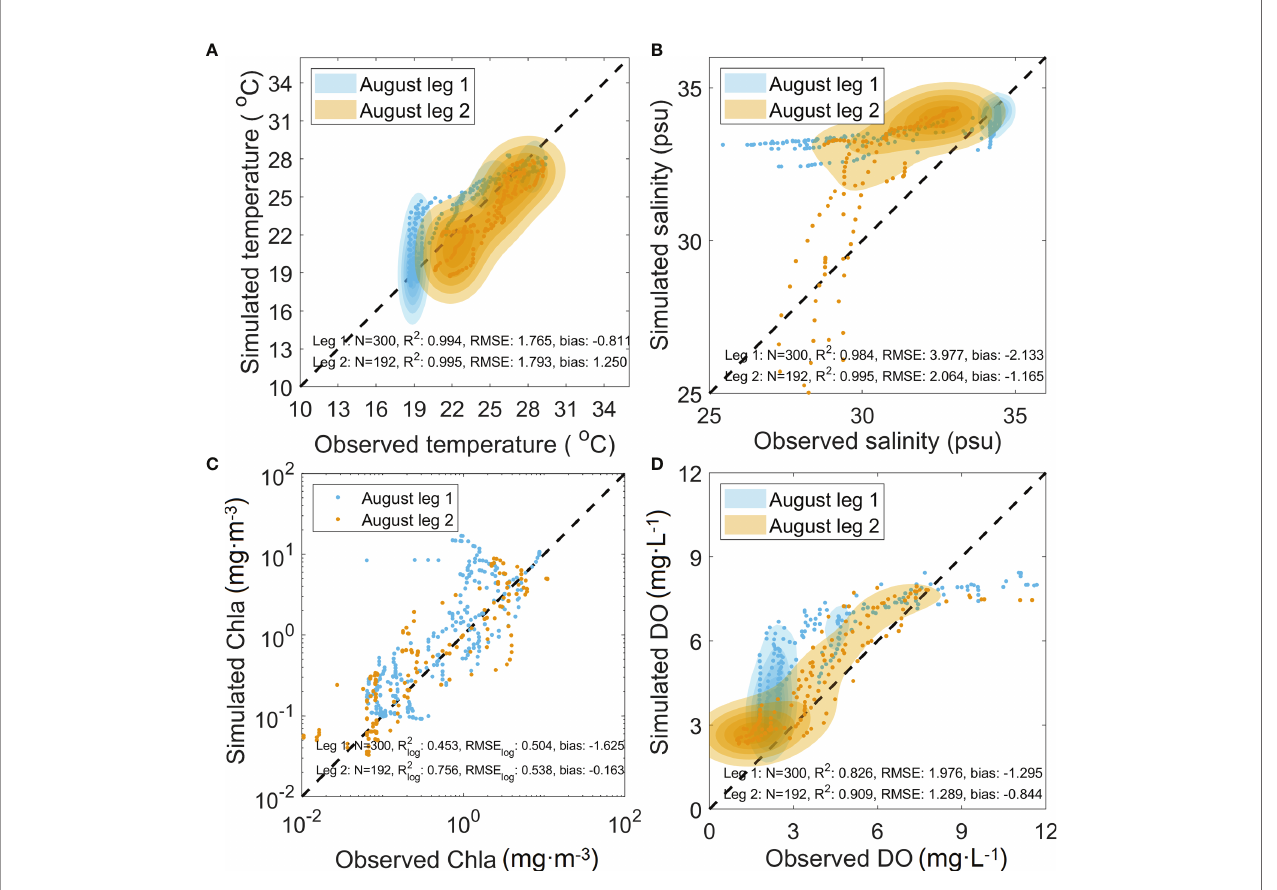
FIGURE 4 | Point to point comparisons between the survey data and the daily-mean model outputs. Measured (A) temperature, (B) salinity, (C) chlorophyll-a (Chla), and (D) dissolved oxygen (DO) data at 1-m-depth intervals were retrieved from stations conducted during Leg 1 (blue) and Leg 2 (orange). The darker patch in Panels (A, B, D) indicates the higher point density. The number of samples ( N ), coef fi cient of determination ( R 2 ), root-mean-square error (RMSE), and bias are exhibited in the fi gure. The coef fi cient of determination and root-mean-square error in Panel (C) were calculated in logarithmic space, which are denoted by R 2 log and RMSE log ,